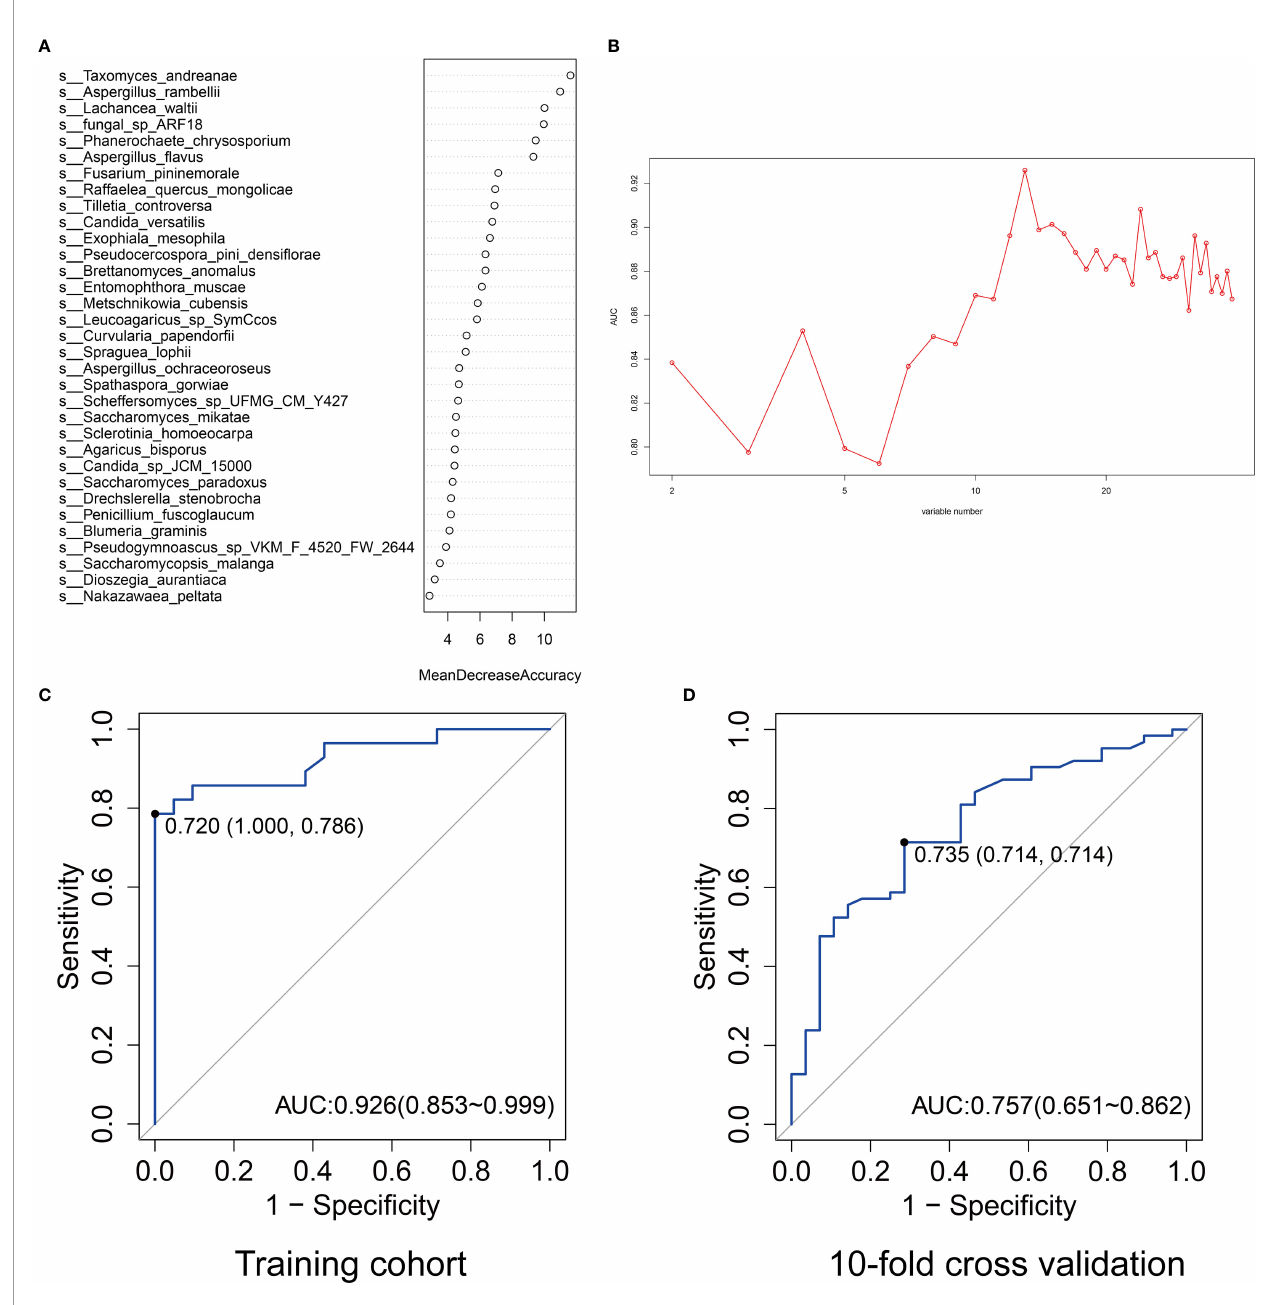
FIGURE 5 | The ranking of importance of gut mycobiota by mean decreased accuracy at the species level (A) . The values of area under the curve (AUC) by different variable number of gut mycobiota (B) . The AUC ranked top when the corresponding variable number was 13. The AUC of the selected 13 gut mycobiota pro fi les for predicting colorectal cancer in the training cohort (C) and 10-fold cross-validation ( D